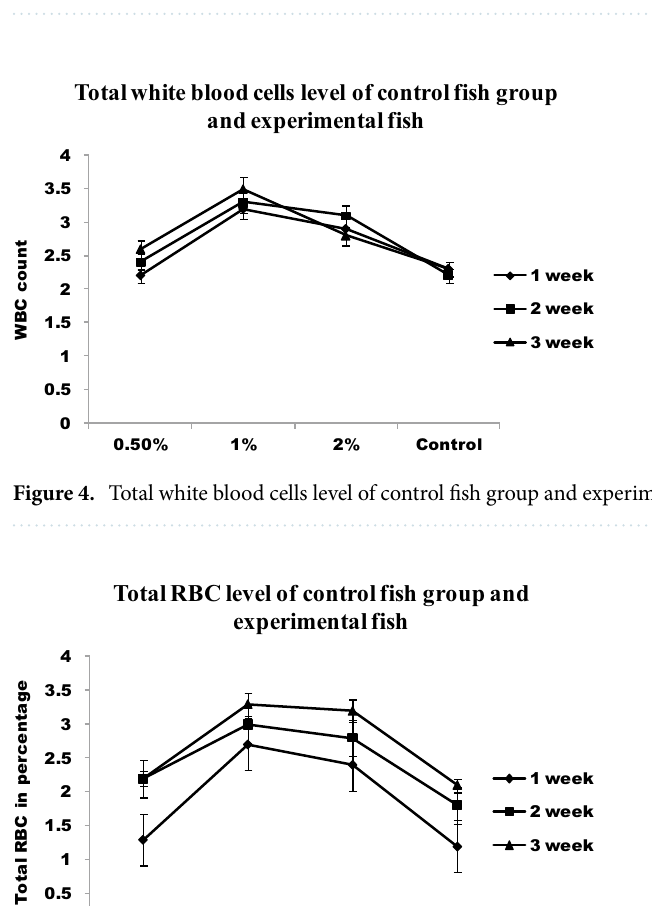
Table 2. Growth and feed consumption efficiency of Lates calcarifer supplemented with varying quantities of chitin derivatives product (CDP). Values within the same row having different superscripts are significantly different (P < 0.05). Data were presented as mean ± SE (n = 3). a,b,c Superscripts represents significant variation based on DMT (Duncan multiple test range).